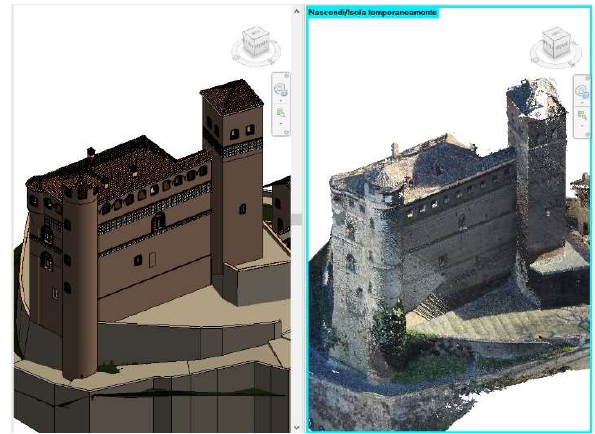
Figure 6. Point cloud usage for supporting modeling